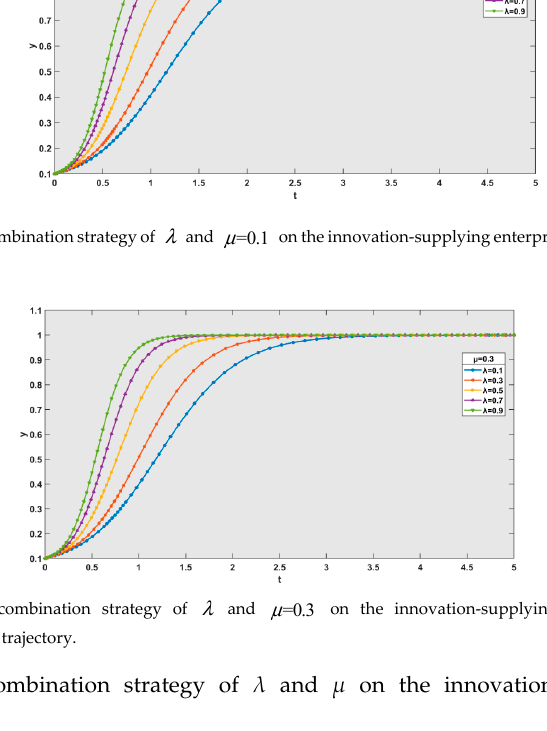
Figure 12. The combination strategy of λ and µ on the innovation-supplying enterprises’ evolution trajectory.